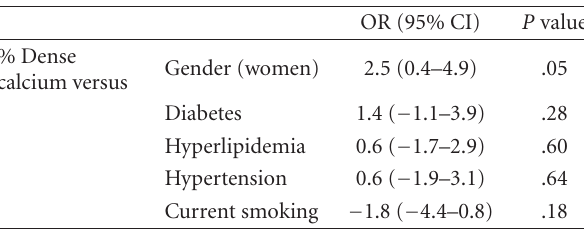
Table 4: Multivariate